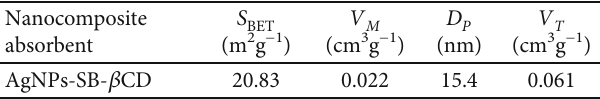
Table 2: Textural characteristics of a novel bagasse – polymer – silver nanoparticle nanocomposite (AgNP-SB- β CD) adsorbent.